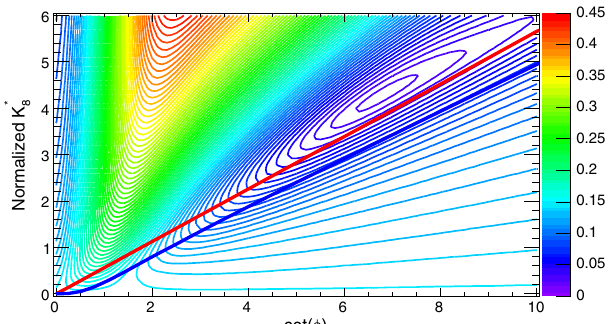
FIG. 4. Same as Fig. 3 but for the beam position region within (cid:5) 1 . 1 σ t